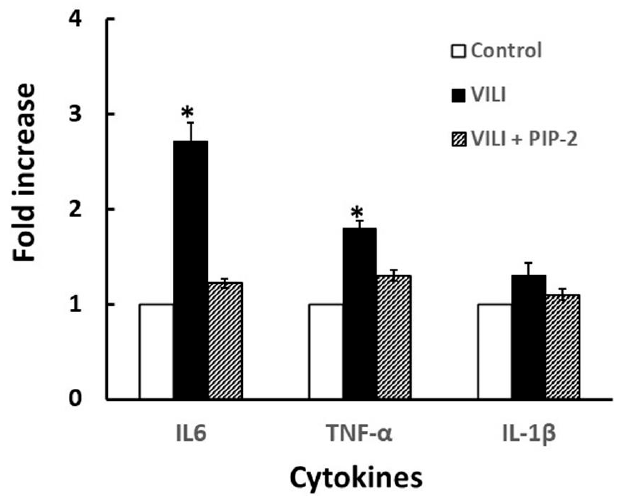
Figure 1. Effect of PIP-2 on cytokines release into BALf. Male mice were studied under conditions described in Table 4. Mice were unventilated (control) or ventilated with high tidal volume (VILI) ± PIP-2 for 6 h. After sacrifice, lungs were lavaged with normal saline and the BAL fluid was analyzed for cytokines. Data is presented as mean ± SD for n = 4 mice, * p < 0.05 vs. corresponding control or VILI values.